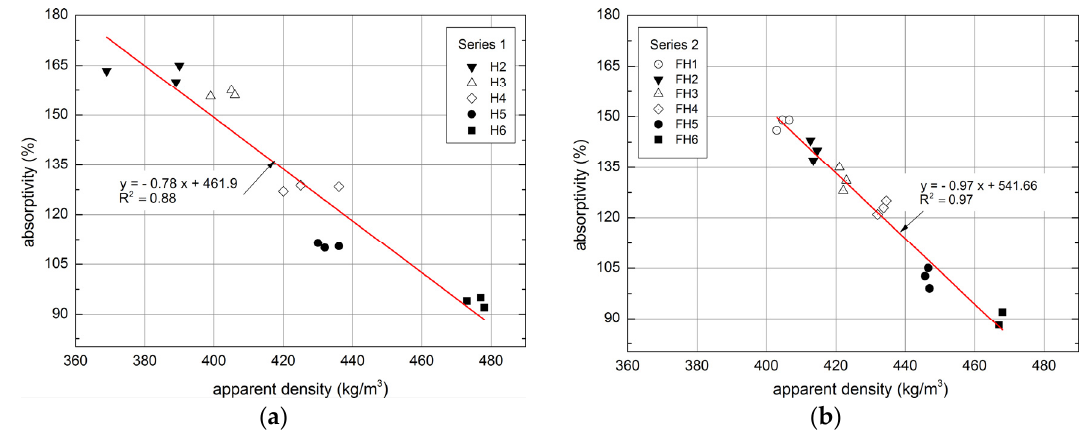
Figure 15. Relationship between absorptivity and apparent density of tested composites: ( a ) Series 1, ( b ) Series 2.